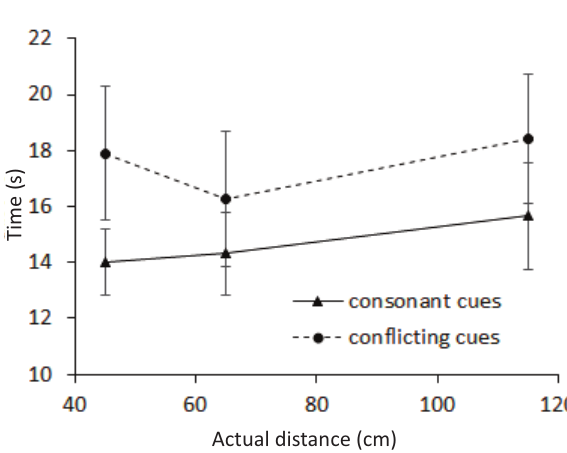
Fig. 3. Mean task completion time depending on the actual image distance in the consonant cues and conflicting cues conditions (error bars represent standard